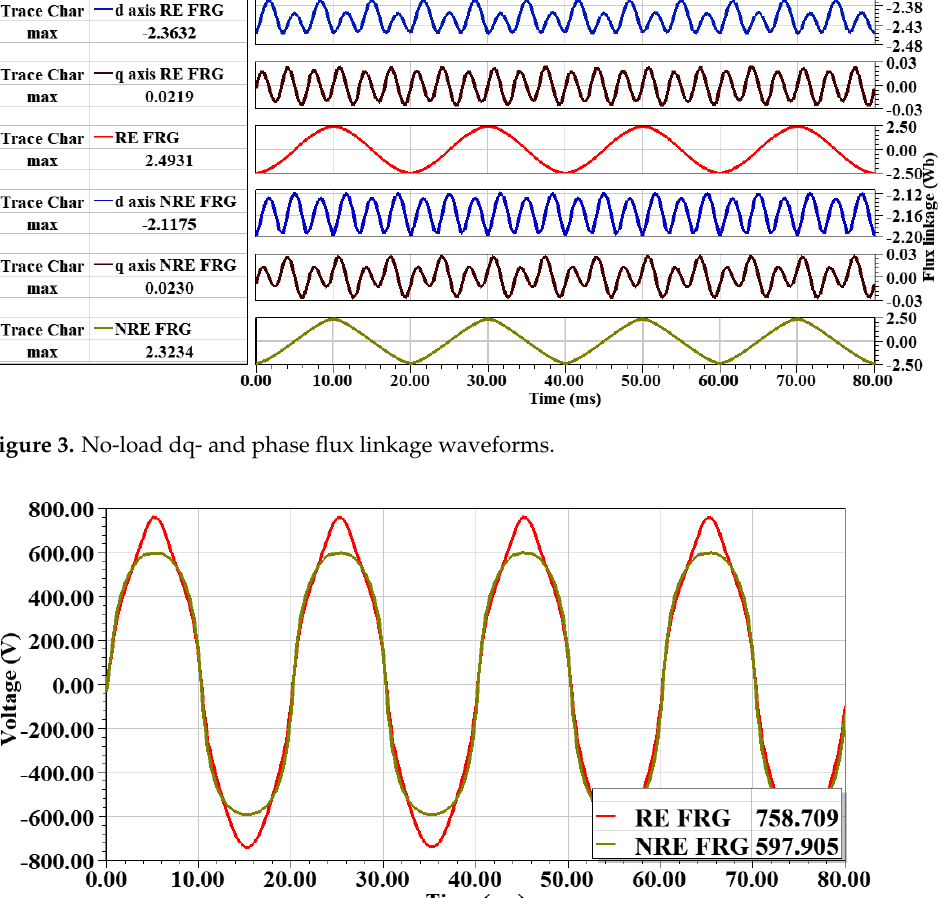
Figure 4. No-load voltage comparison at 375 r/min.